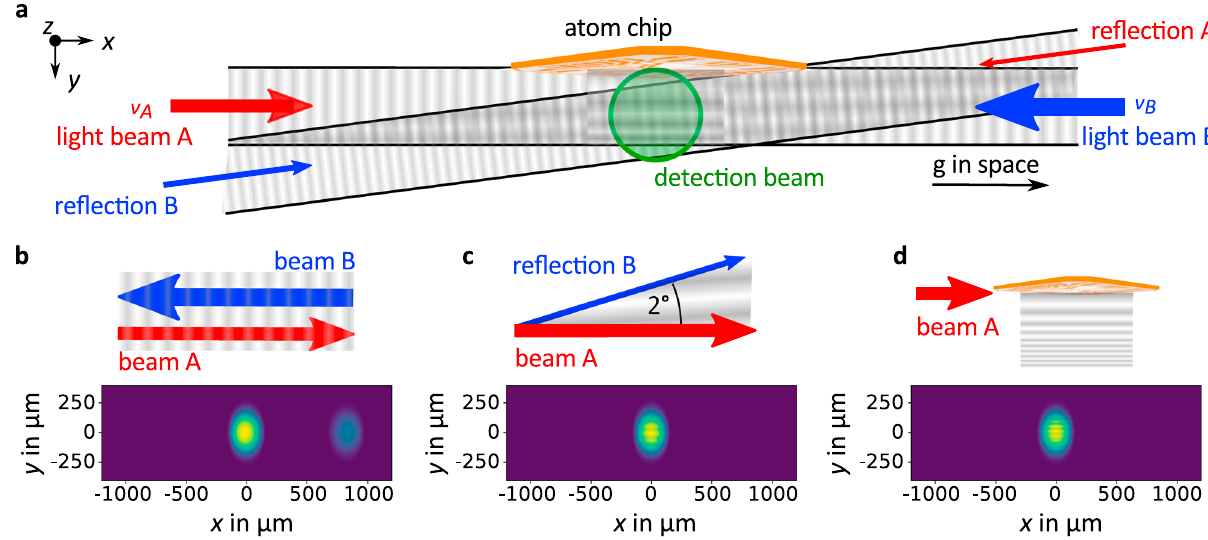
Fig. 1 Optical setup. Optical arrangement for space-borne light-pulse interferometry employing a BEC and associated diffraction processes. a , b After release of the multi-component rubidium BEC two light beams, A and B, with different frequencies ν A and ν B , and intensities travel in opposite directions parallel to the atom chip and generate a moving optical lattice driving Bragg processes, which coherently transfer momentum to the atomic wave packet along the x -direction ( b ). Two additional light beams tilted by two degrees emerge due to re fl ections of the beams A and B on the optical viewports. c Their interference with the lattice beams gives rise to a traveling spatial intensity modulation in the y -direction modifying the BEC wave function as well as inducing weak double-Bragg processes in x-direction (not shown). d In addition, the light beams are diffracted at the atom chip and the arising interference modulates their intensity in y -direction. The various effects of the light pulses on the multi-component wave packet are detected by a CCD- camera recording the shadow of the BEC irradiated by light (green circle) from the z-direction. Earth gravity pulls along the x -direction during space fl ight, and along the x – z diagonal on